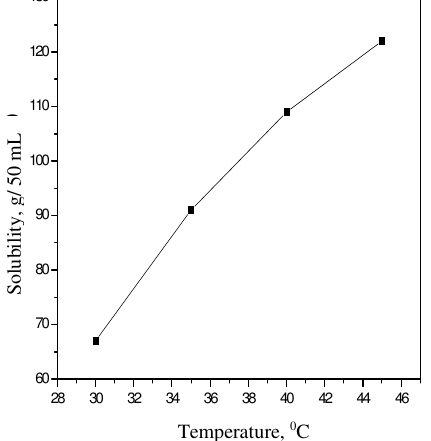
Figure 1. Solubility of ZSHH as a function temperature in aqueous